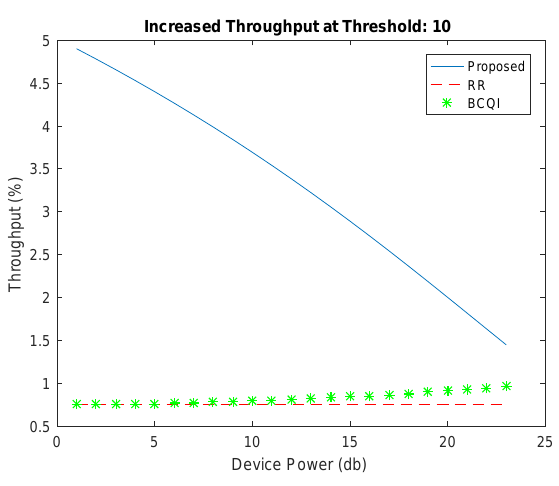
Figure 7. Throughput at threshold